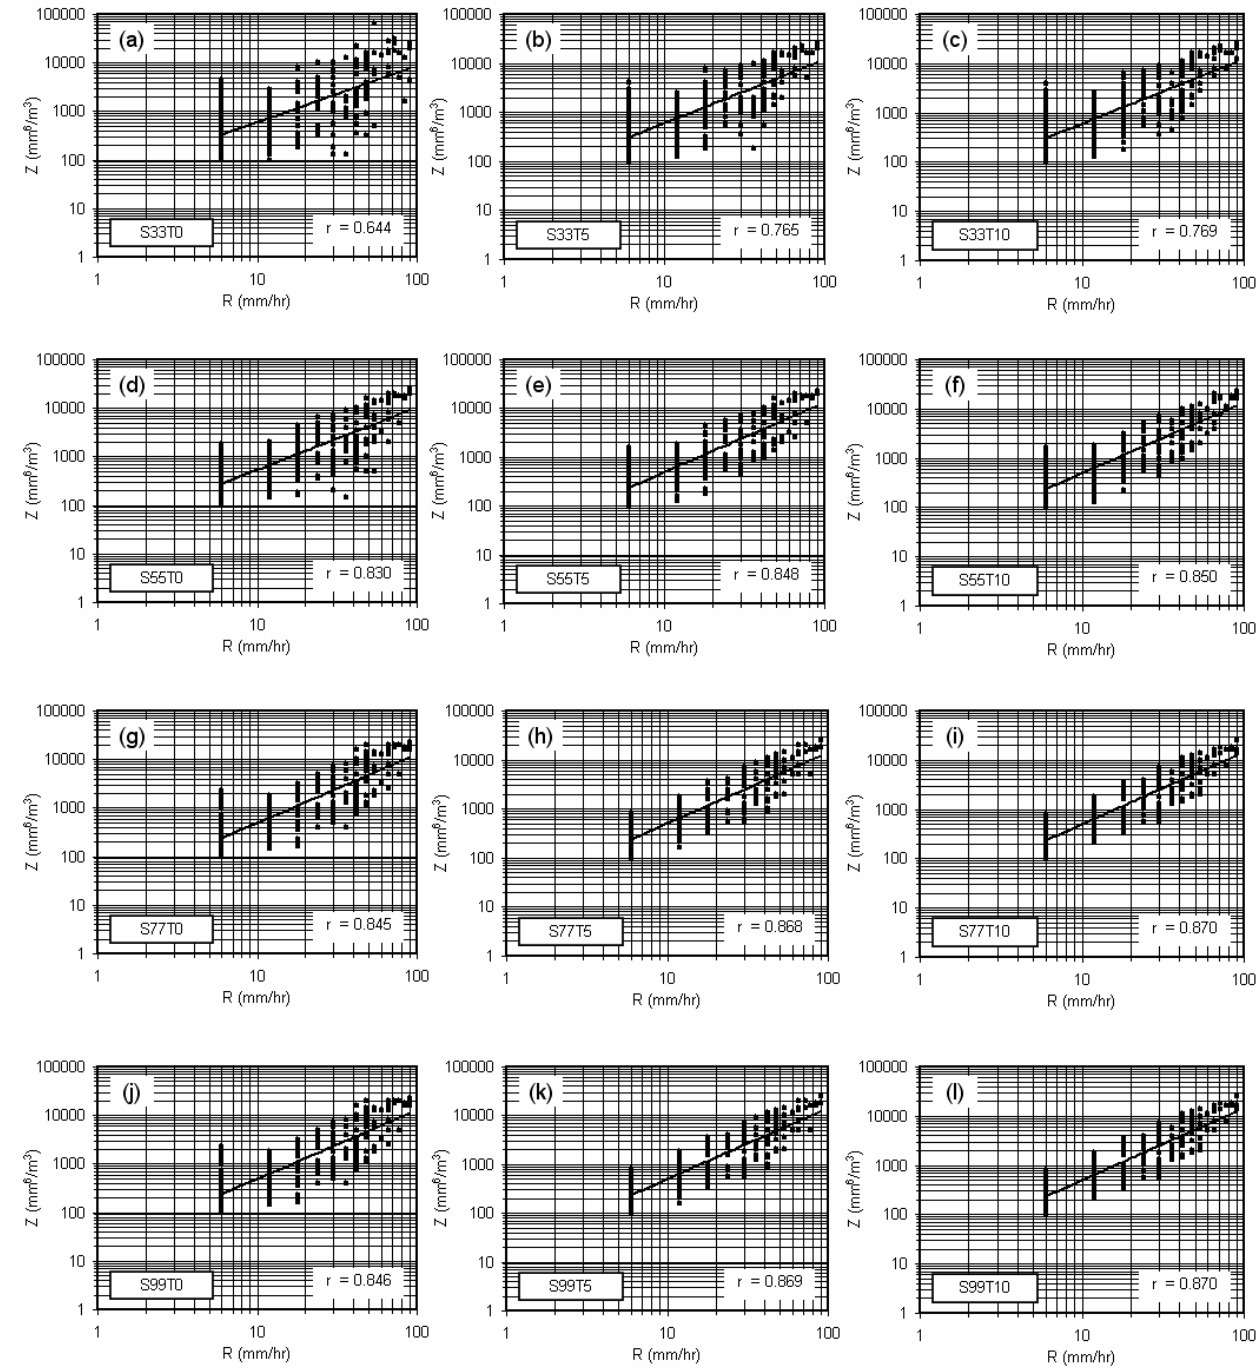
Fig. 7. Scatter plots of Z e − R pairs for different WCMM scenarios during 15–18 September 1999.